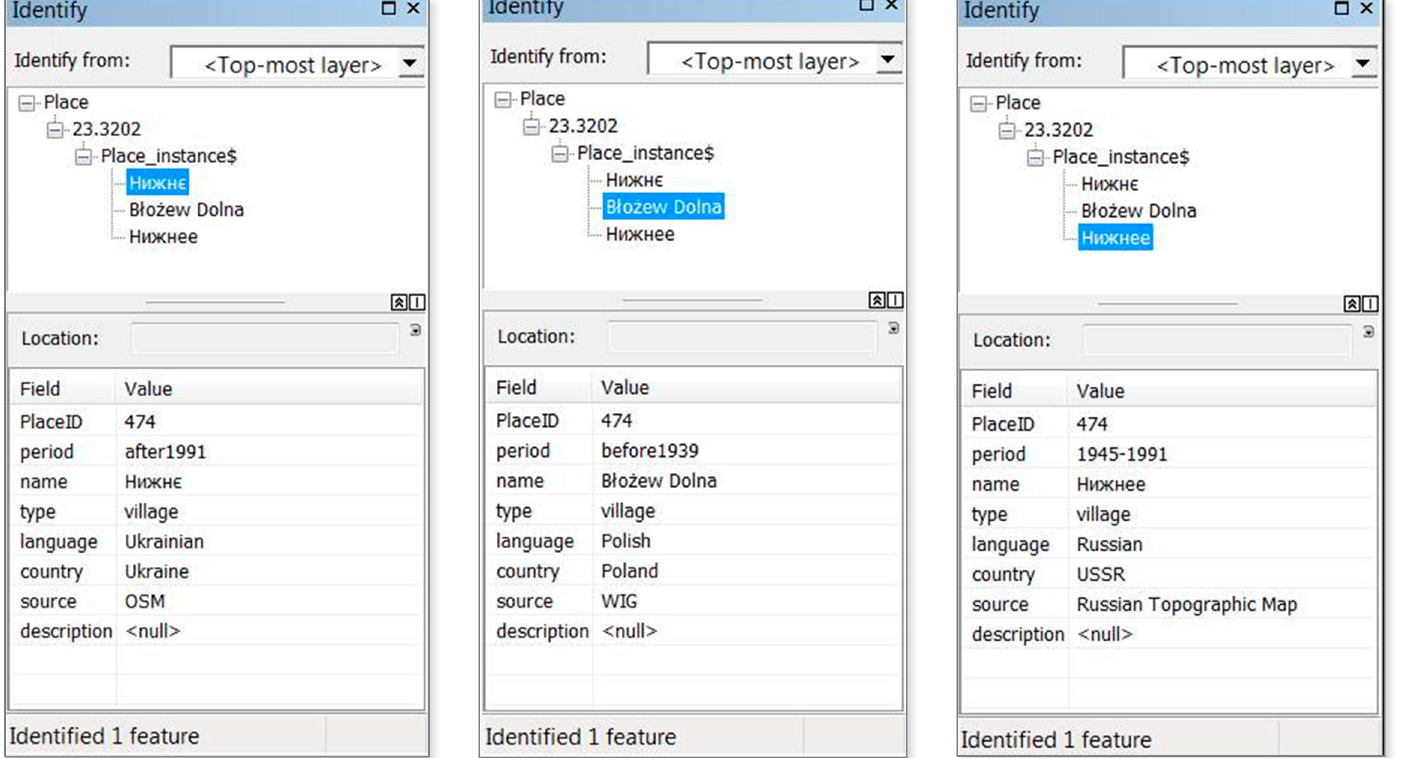
Figure 8. Simultaneous states of the selected locality (object instances) (source: own study).